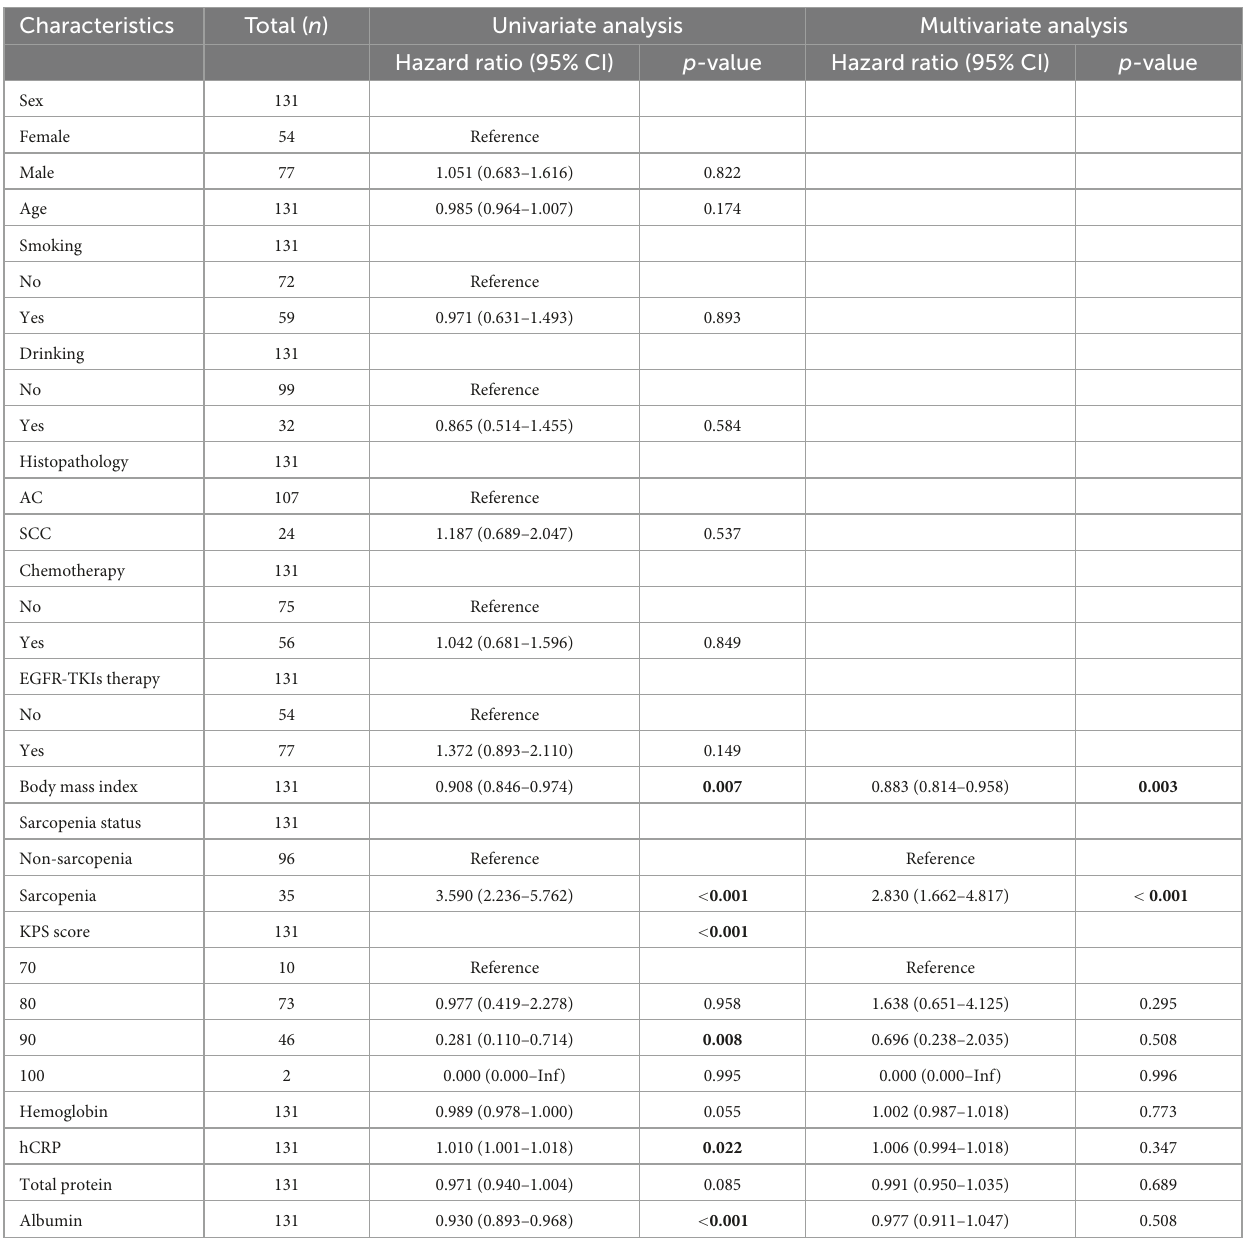
TABLE 3 Results of Cox regression analysis for PFS for all